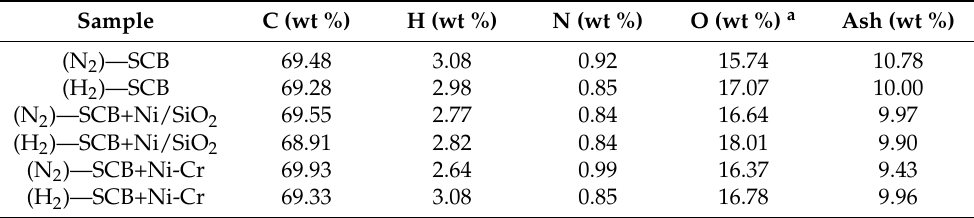
Table 2. Elemental biochar